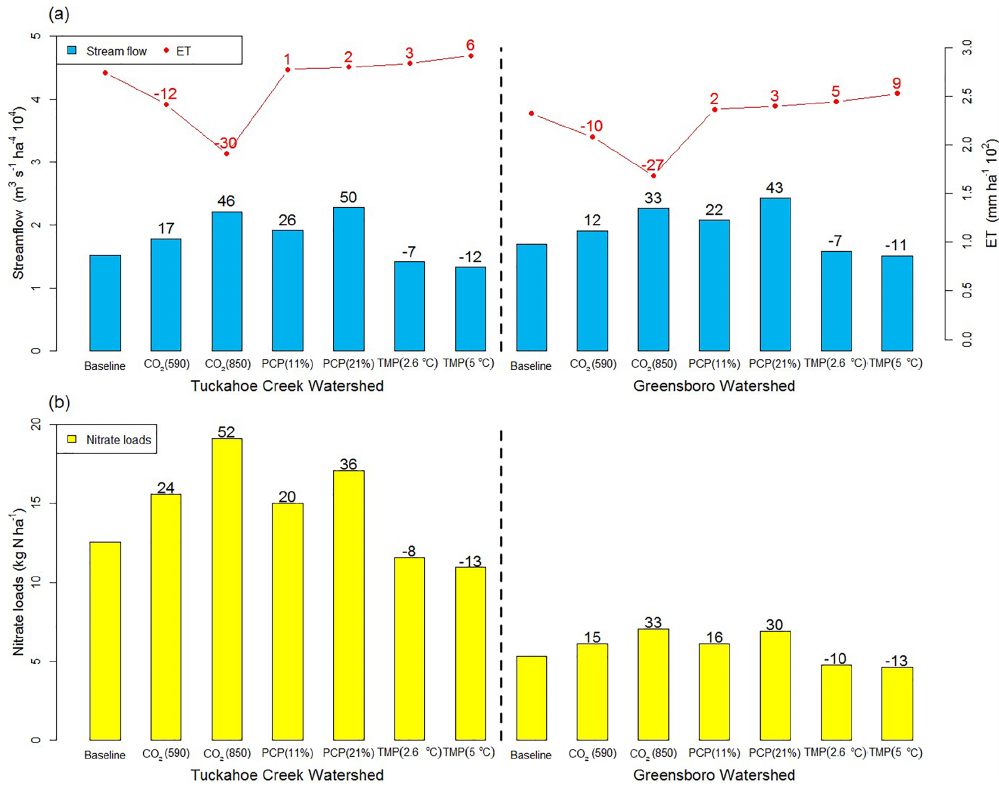
Figure 4. The 14-year average of annual hydrologic variables under the baseline and climate sensitivity scenarios at the watershed scale: (a) streamflow and evapotranspiration (ET), and (b) nitrate loads. Note: the red and black numerical values above the bar and dot graphs, respectively, indicate the relative changes (%) in hydrologic variables for climate sensitivity scenarios relative to the baseline scenario (relative change (%) = (sensitivity scenarios − baseline) / baseline × 100). PCP and TMP stand for precipitation and temperature, respectively.